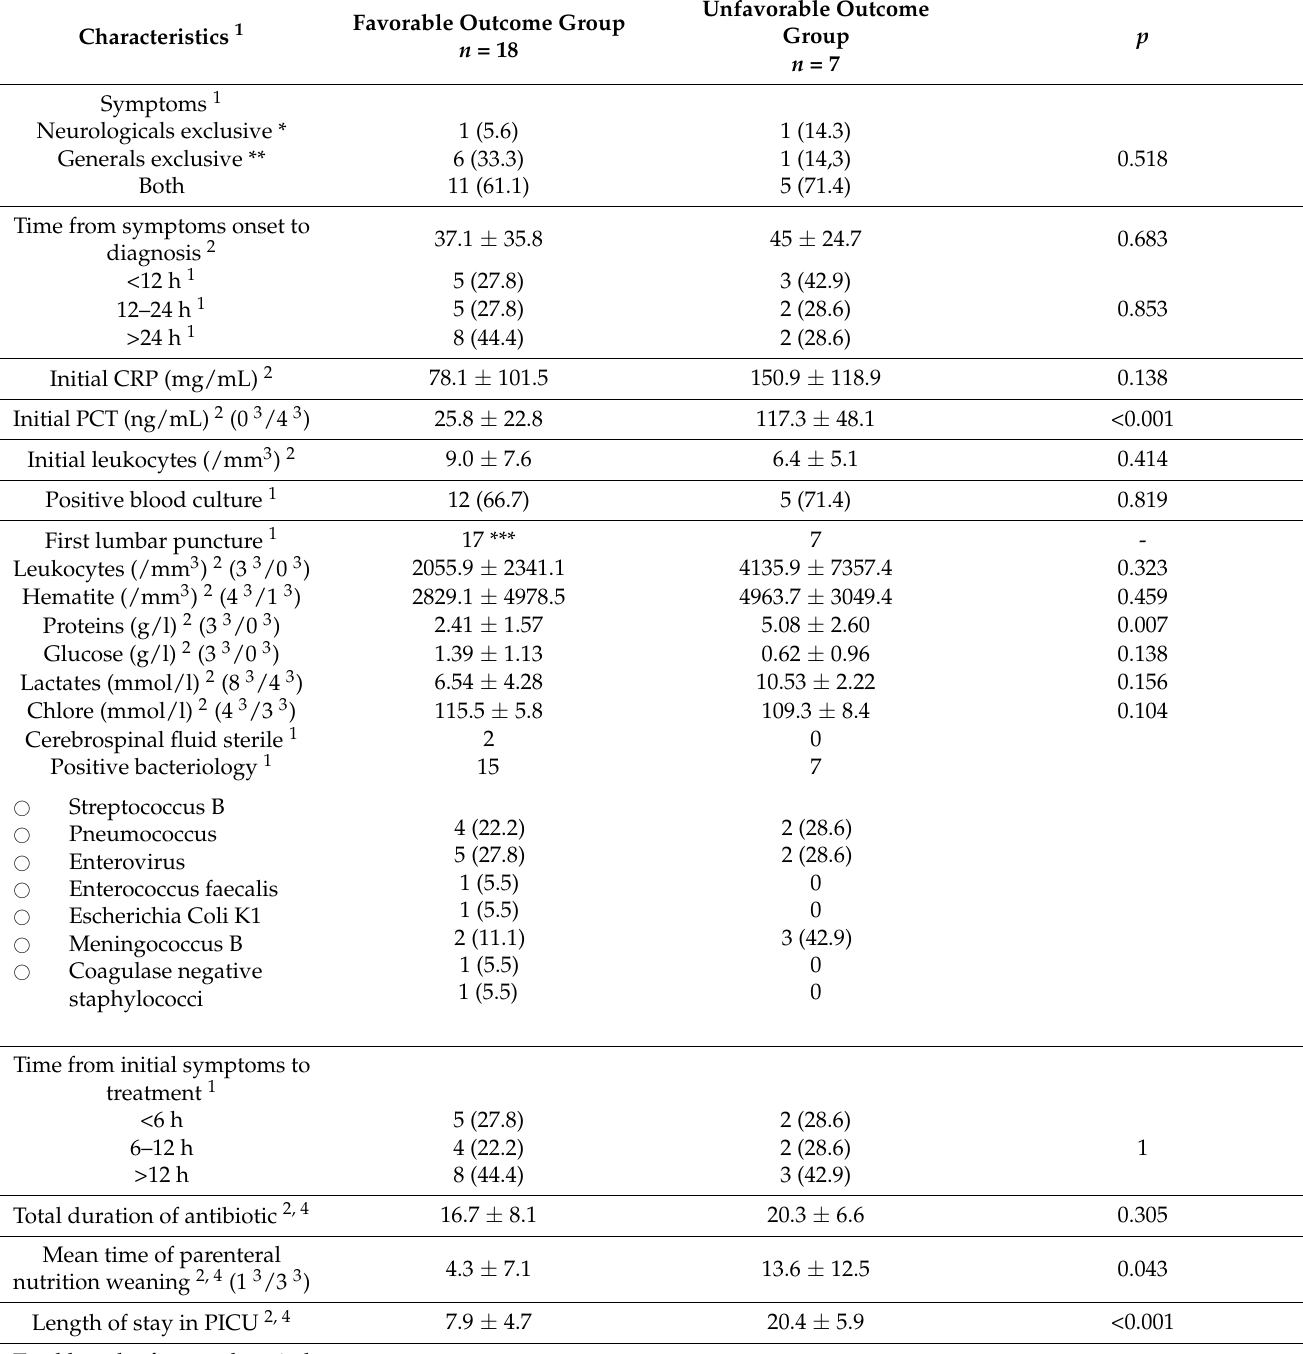
Table 2. Bacteriological, clinical, and management characteristics of recorded patients, accord- ing to